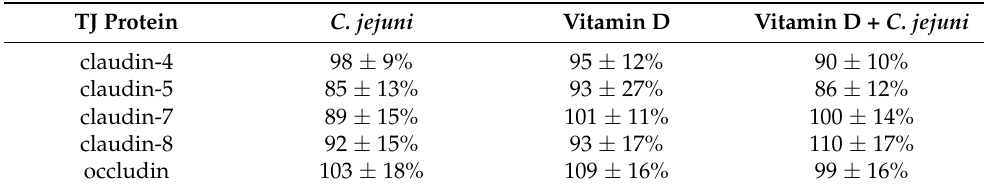
Table 1. Tight junction (TJ) protein expression change from control level (100%) in HT-29/B6-GR/MR cells after C. jejuni infection with or without addition of 200 nM vitamin D.